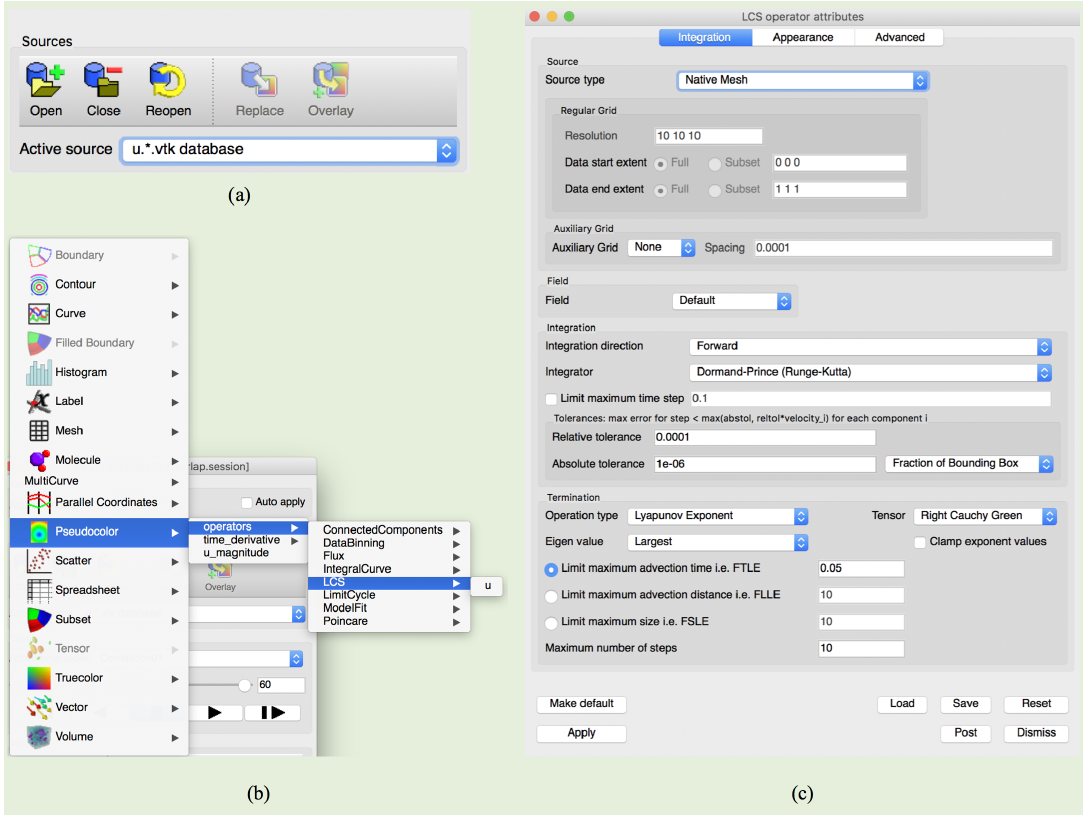
Figure 5. VisIt GUI interface showing steps to illustrate finite-time Lyapunov exponents (FTLE), e.g., ( a ) active source must be set on velocity field, ( b ) sequence to plot FTLE (e.g., Lagrangian Coherent Structures, LCS), and ( c ) attributes for plotting, e.g., accuracy tolerances, solver-type, etc.